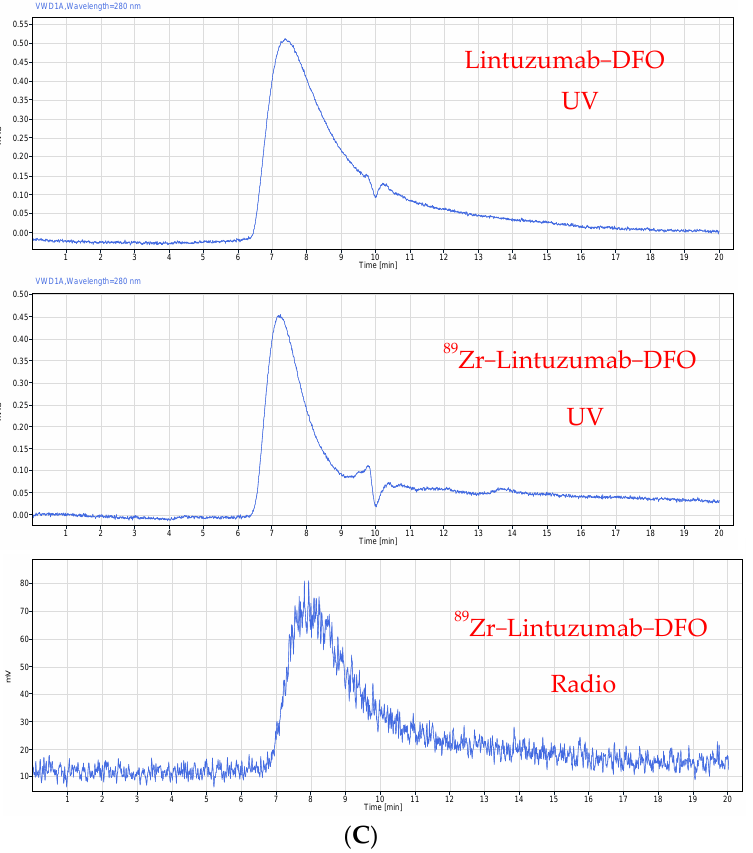
Figure 1. Radiolabeling of lintuzumab with 89 Zr and its in vitro binding to CD33. ( A ) Binding of Lintuzumab − DFO conjugate to recombinant human CD33 protein is demonstrated via ELISA. ( B ) Binding of Lintuzumab − DFO conjugate to human cancer cell lines that express CD33 is demon- strated via immunofluorescence staining using a flow cytometer. ( C ) HPLC trace chromatograms ran on purified antibody conjugate (upper panel) and radiolabeled conjugate at a wavelength of 280 nm (middle panel UV trace, lower panel radioactivity trace).